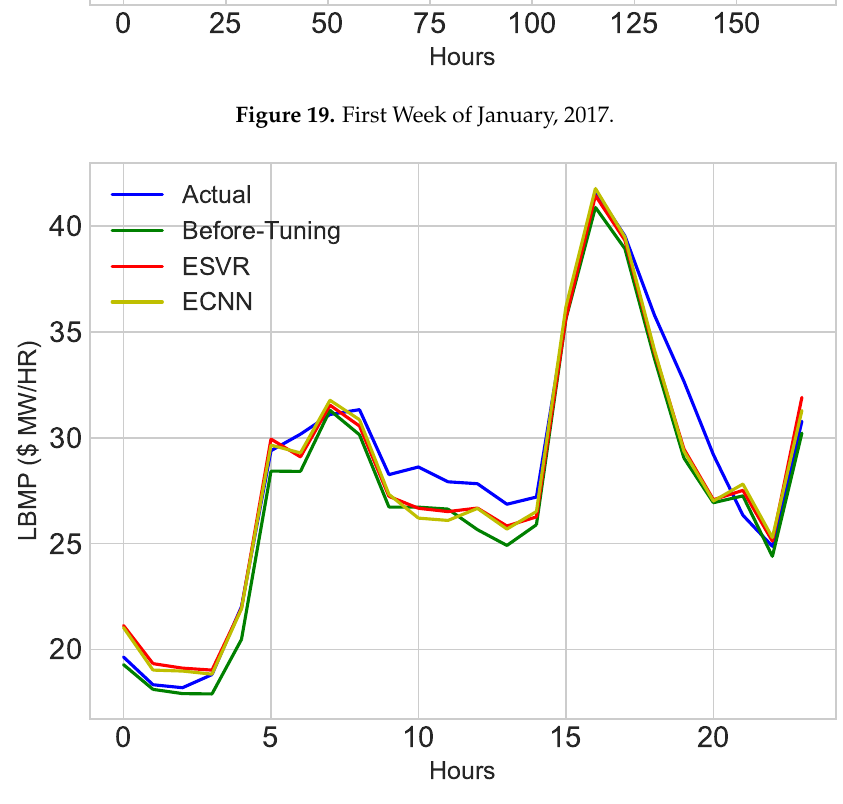
Figure 20. 1 January